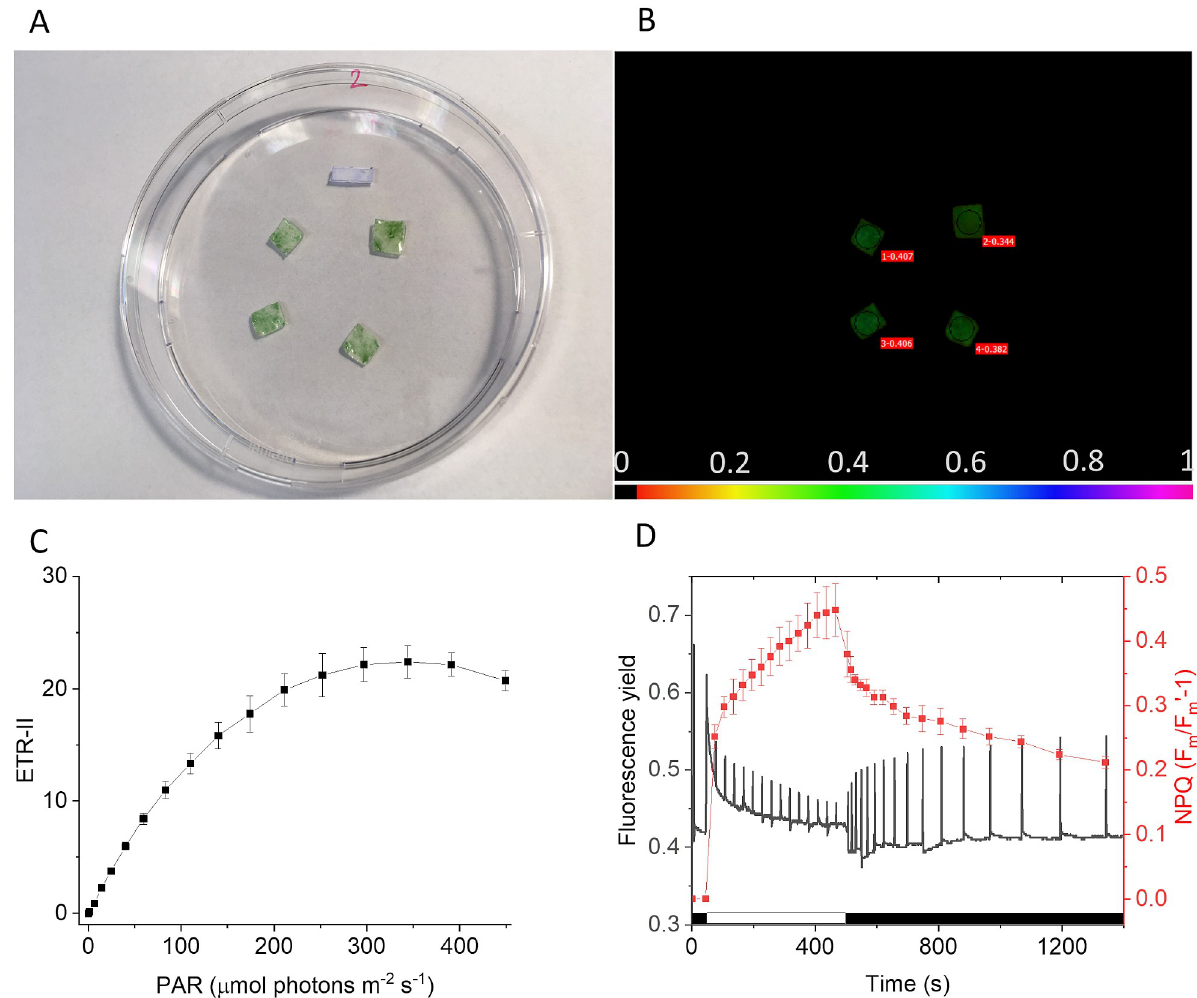
Fig 6. Pulse-Amplitude Modulation (PAM) chlorophyll fluorescence imaging of the GMF carrying Synechocystis biofilm. (A) Colour photograph of the Synechocystis biofilms grown on 3X PHB coated GMF membranes in a Petri dish (representing one biological experiment with four technical replicates, which were subjected to PAM measurement). The white bar represents 1 cm length. (B) False-colored chlorophyll fluorescence image showing the maximum quantum yield of PSII (F v /F m ) values in the selected areas of interest (black circles). The color bar in panel B represents the color coding of F v /F m values (black: F v /F m = 0, magenta: F v /F m = 1). Measurements of F v /F m were performed on two independent biological replicates, each representing four biofilms as technical replicates. (C) Electron transport rate through Photosystem II (ETR-II) vs. irradiance curves of the Synechocystis biofilms (n = 4, mean ± S.D.), (D) representative fluorescence induction-recovery curves of the Synechocystis biofilms (black trace) and the calculated non-photochemical quenching (NPQ, red traces, (n = 4, mean ± S.D.). Black bars represent the dark phases, white bar represents the illumination phase using actinic light (450 μ mol photons m -2 s -1 photon flux density).